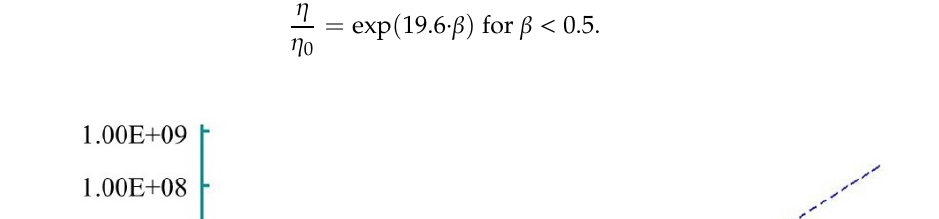
(b) Figure 8. Complex relative viscosity ( η / η 0 ) vs. conversion for polymerization (based on references [83], reproduced with copyright permission from Elsevier, 1997): ( a ) at 120 °C, 140 °C and 160 °C; ( b ) at 120 °C and 150 °C. 4.3. The Castro ‐ Macosko Model (1982) Adopted by Taki (2017) The Castro ‐ Macosco viscosity model was initially developed for thermosets [85]: 𝜂 (cid:3404) 𝐴 (cid:3086) ∙ exp (cid:4672) (cid:3006) (cid:3334) (cid:3019)(cid:3021) (cid:4673) ∙ (cid:3428) (cid:3004) (cid:3282)∗ (cid:3004) (cid:3282)∗ (cid:2879)(cid:3004) ∗ (cid:3432) (cid:3002)(cid:2878)(cid:3003)(cid:3004) ∗ , (22) where 𝐶 (cid:3034)∗ is the gel point of the material, and 𝐴 (cid:3086) , 𝐴, 𝐵, 𝐶 ∗ are rheological constants. Although the Castro ‐ Macosko model was developed for thermoset polymers, it was modified by Taki et al. [80] to describe the AROP of CL: